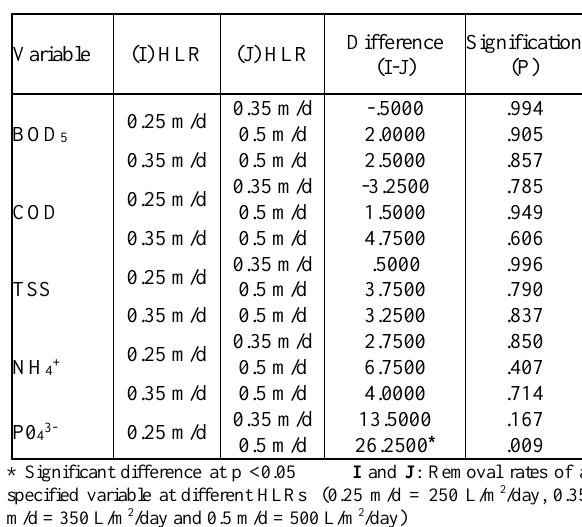
Table 4. ANOVA test of organic and nutrient pollutions removal rates according to HLRs